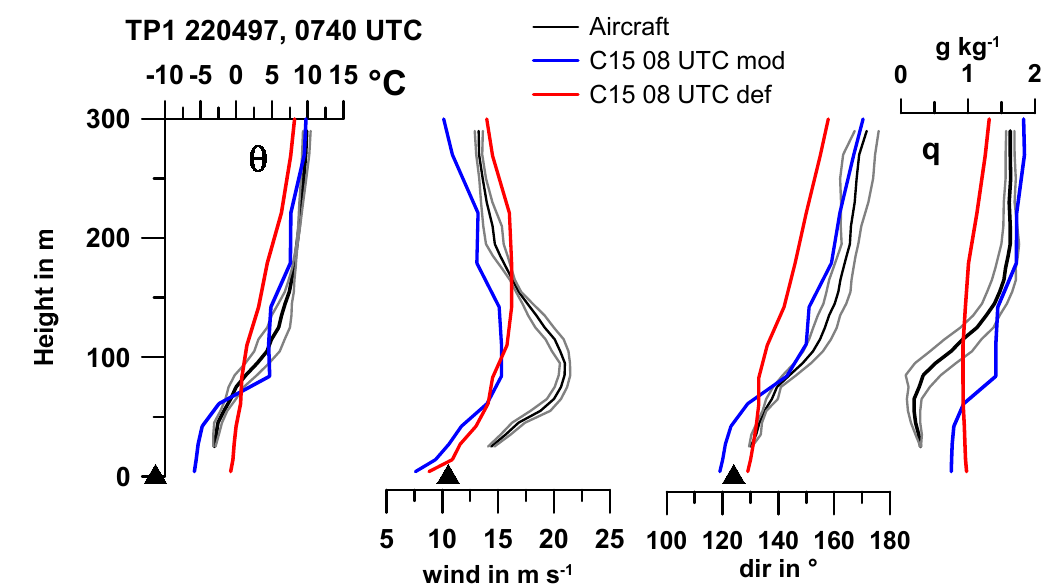
Figure 9. Averaged aircraft profiles for 07:40 UTC (black line) and simulations (def: red, mod: blue) for 08:00 UTC 22 April 1997 for profile P1 (see Table 1). The grey lines associated with the aircraft data show the standard deviation of the data in the vertical bins. The displayed variables are potential temperature ( θ ), wind speed, wind direction, and specific humidity (q). The data of AWS A4 at 07:45 UTC are shown as triangles.